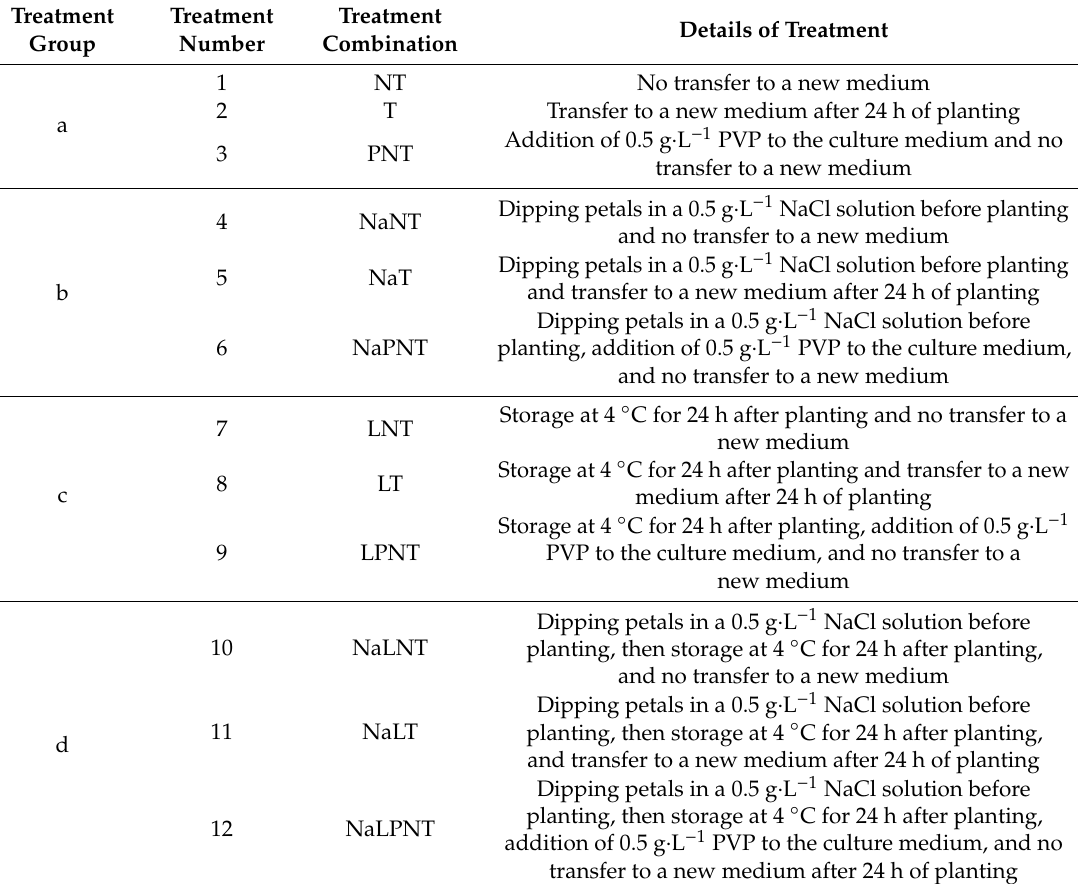
Table 1. The details on the treatment